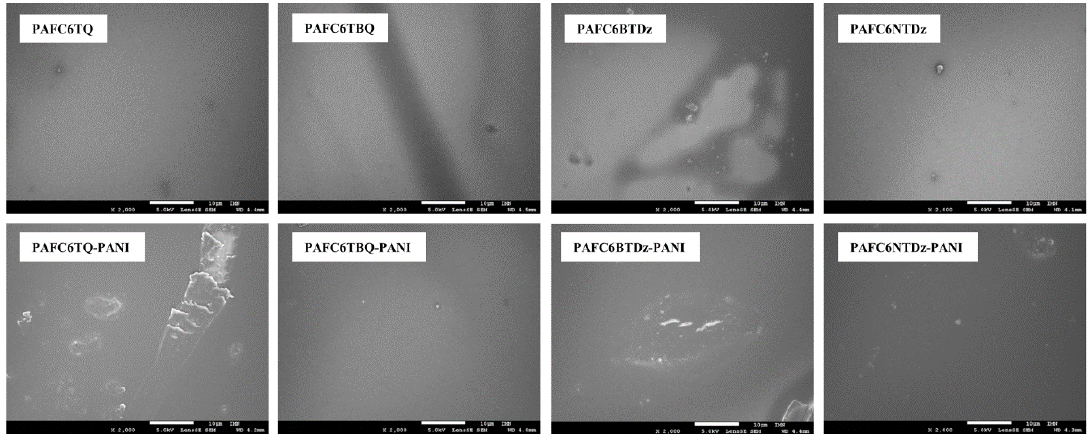
Figure 5. SEM images of 1D- and 2D-conjugated copolymers deposited on glass/ITO/MoO 3 substrates. Scale bar: 10 μ m.